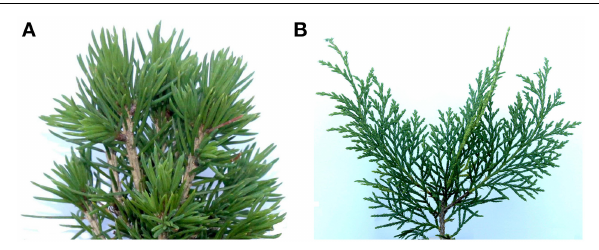
FIGURE 1 | Photographs of a portion of the crown of two of the 15miniature coniferous trees. (A) Picea abies Tompa (Norway Spruce) and (B) Microbiota decussata Gold Spot (Russian Arborvitae), as representative examples of the needlike and scalelike leaf groups, respectively.